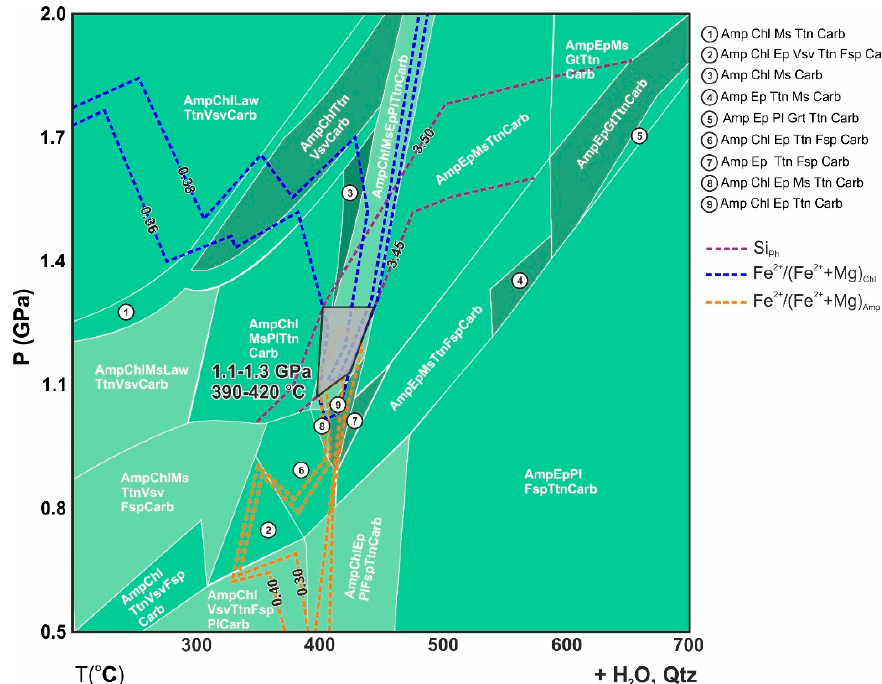
Figure 28. P–T pseudosection calculated for the Jaklovce metabasite D1 peak metamorphic stage using a modified composition of the JAK-30 sample (Table 9) in the NCKFMASTO system by Perple_X thermodynamic software [30,102] with isopleths of Fe / (Fe + Mg) for Chl and Act and content of Si-in-Ph.